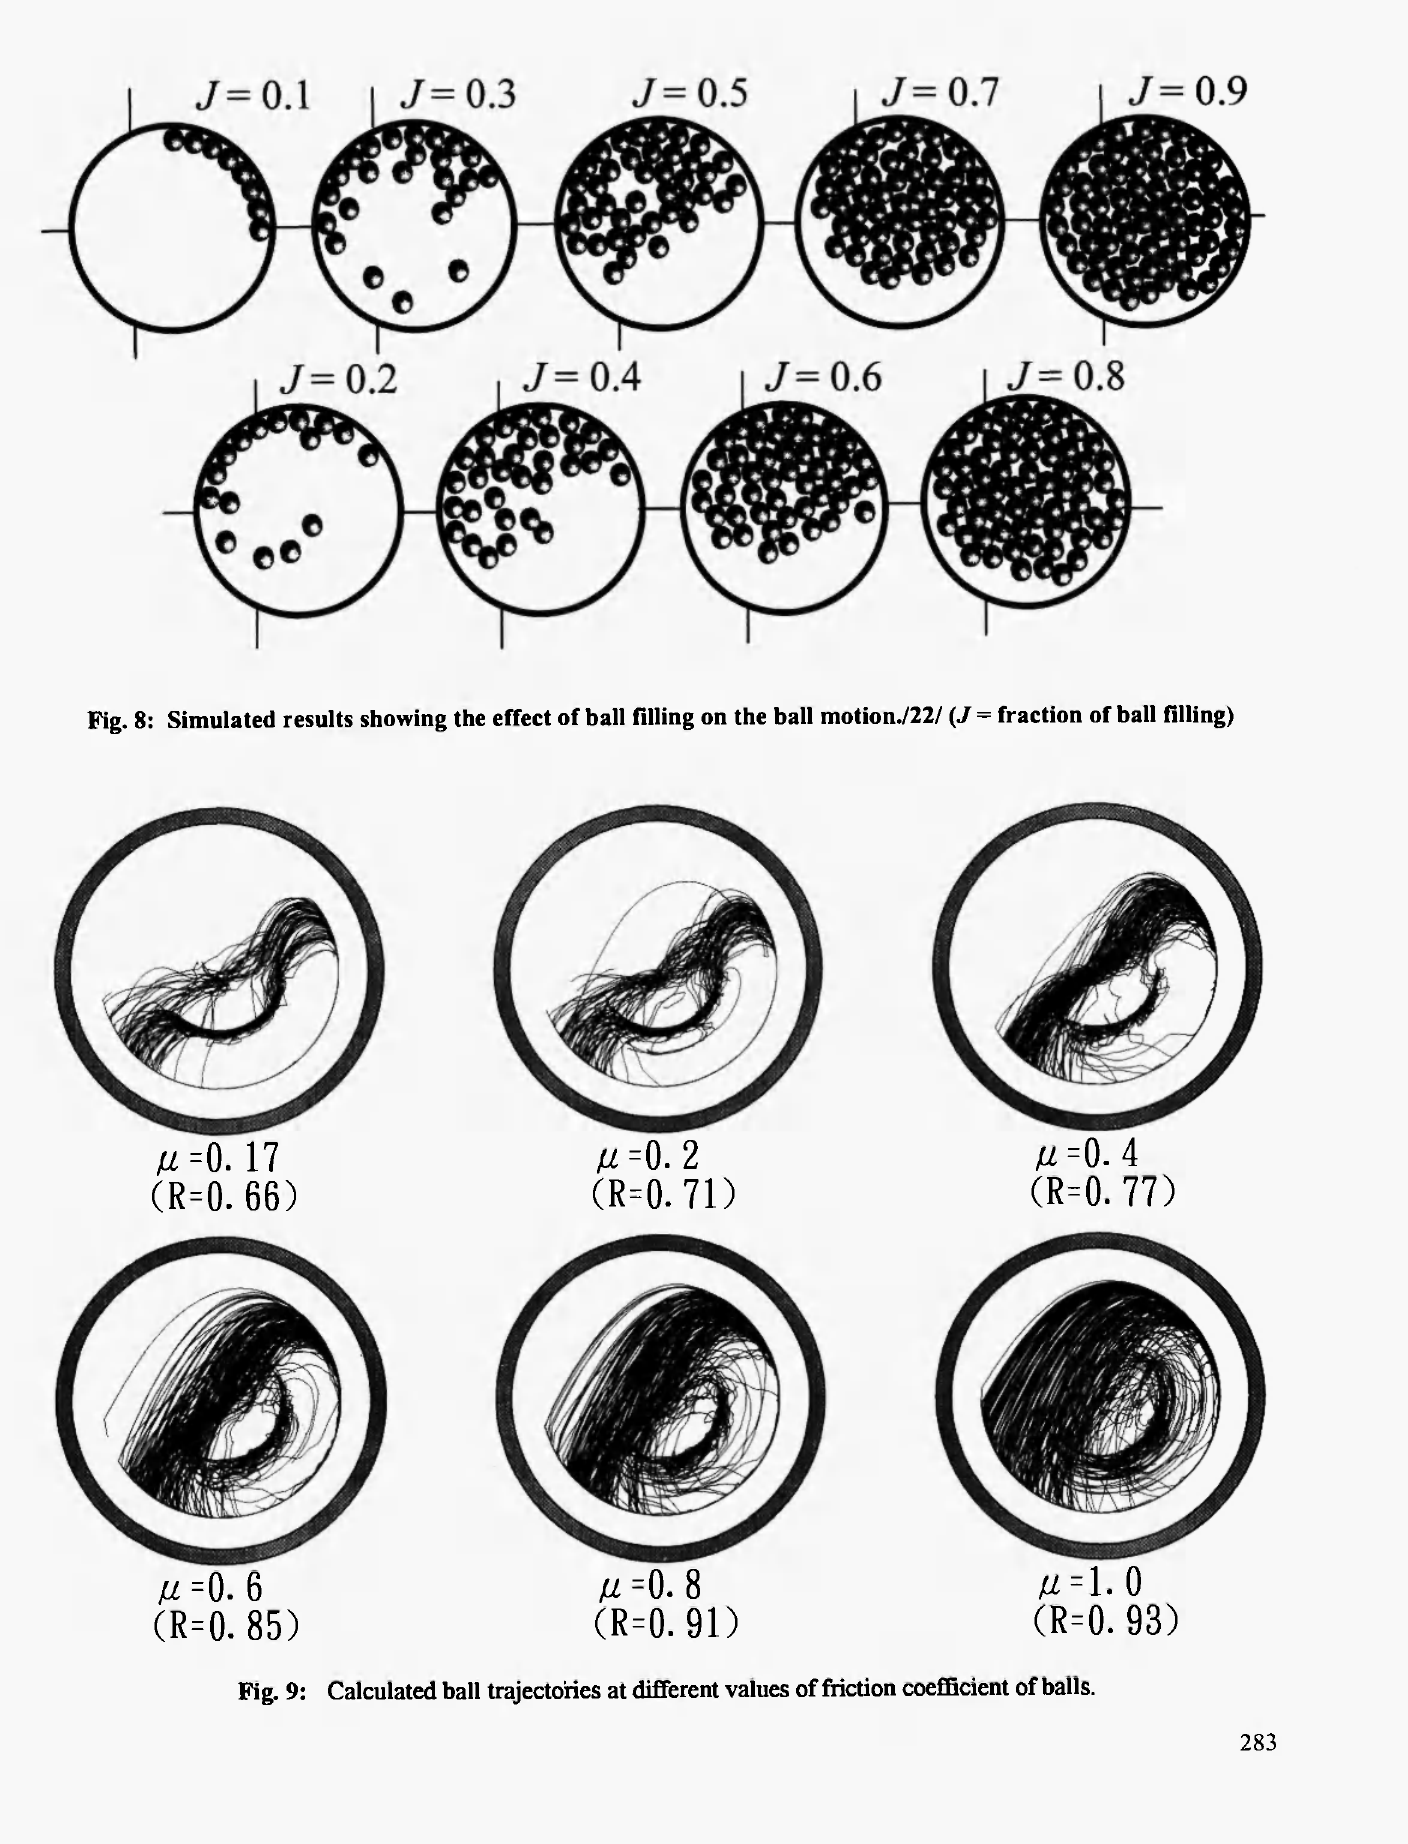
Fig. 9: Calculated ball trajectories at different values of friction coefficient of